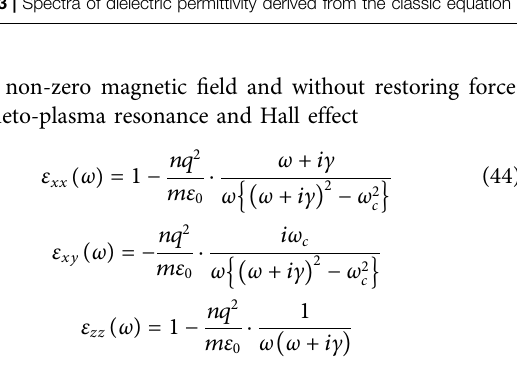
FIGURE 3 | Spectra of dielectric permittivity derived from the classic equation of motion for electrons (A) Lorentz-type spectra, (B) Drude-type spectra.